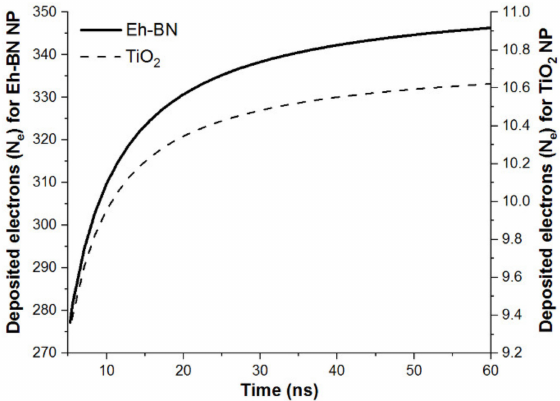
Figure 9. Charging characteristics of Eh-BN and TiO 2 in MO.